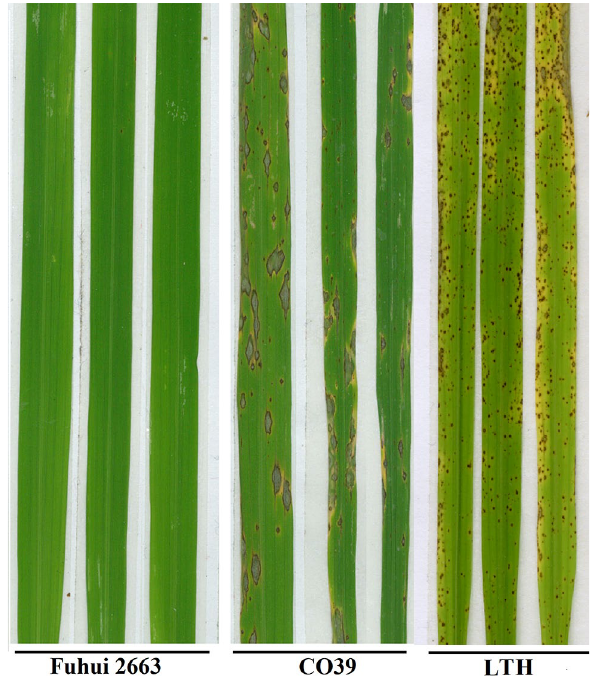
Figure 1. Fuhui 2663 is resistant to KJ201 under laboratory conditions. Plants of Fuhui 2663 and CO39 at the 3–4-leaf stage were transferred to an inoculation chamber under high humidity, and 25 mL of spore suspension of M. oryzae isolate KJ201 was sprayed with an air compressor. The inoculated plants were transferred to a plastic box covered with a wet sponge, cultured in a dark room (95–100% RH, 25 °C) for 24 h, and then transferred to a greenhouse at 25–28 °C for 6 days, after which photographs were taken.